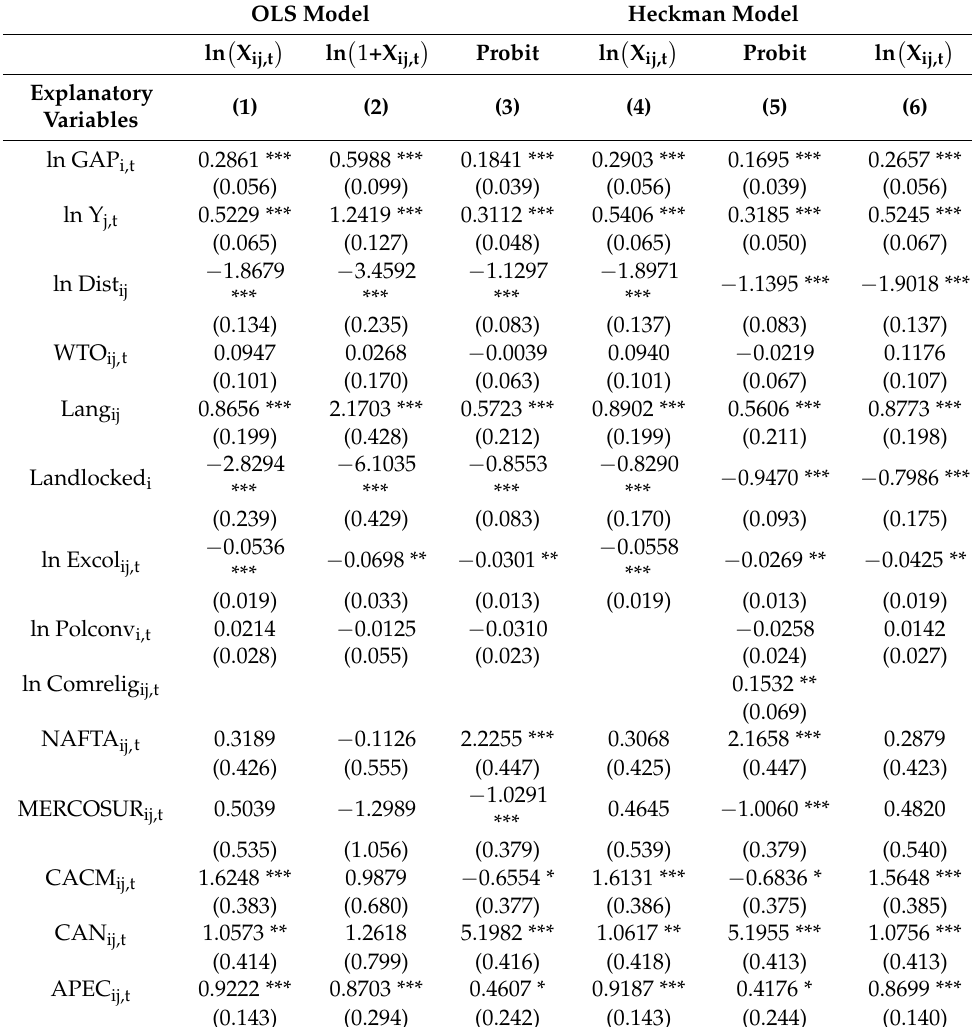
Table 5. Empirical Results of the OLS and Heckman